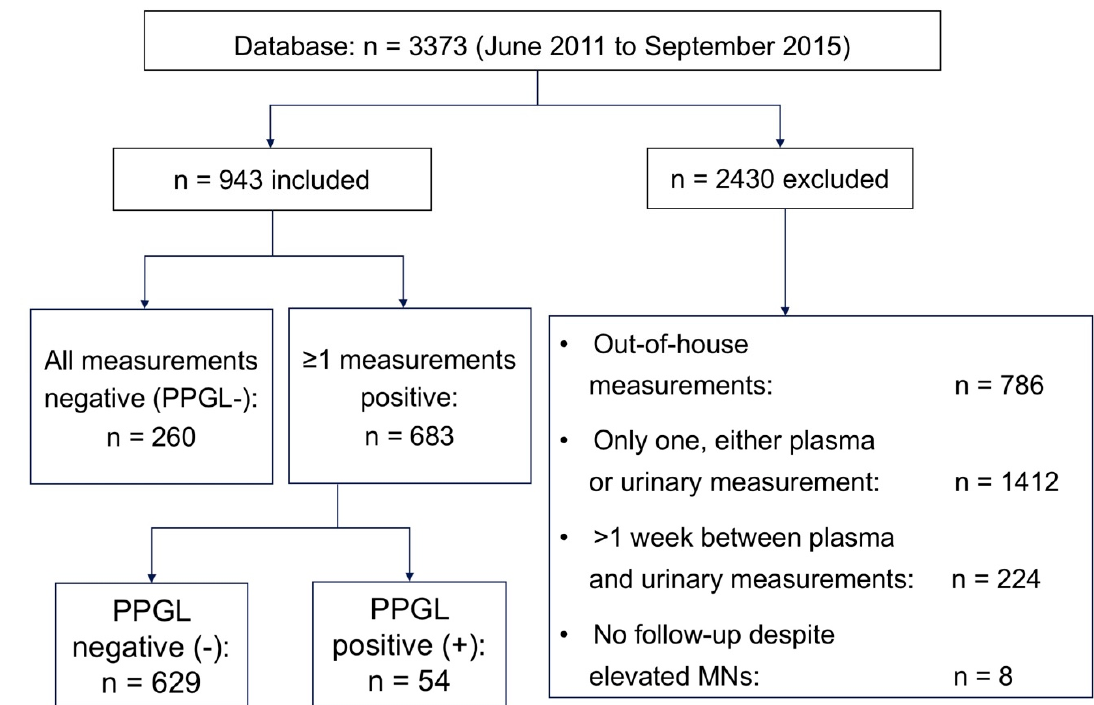
Figure 1. Flow-chart of patients.